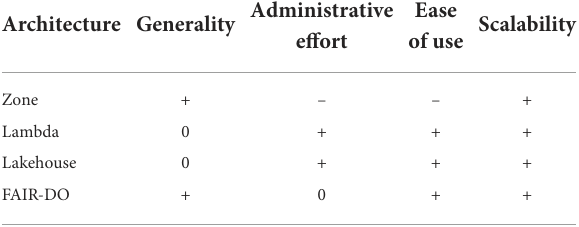
TABLE 1 Comparing the four presented